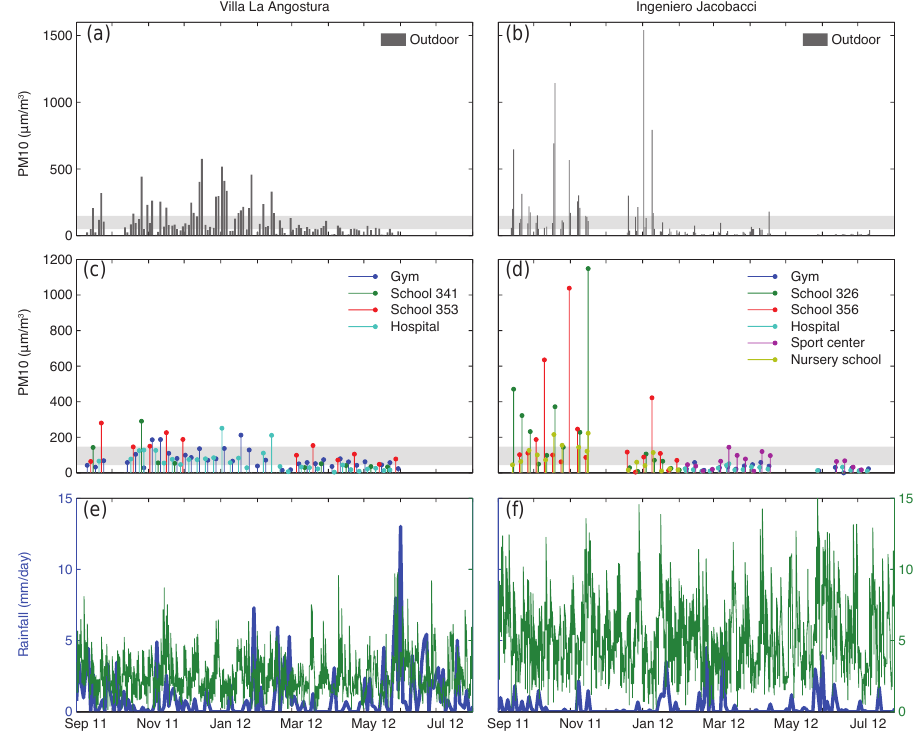
Figure 7. PM 10 concentrations between September 2011 and July 2012 for (a) Villa La Angostura (outdoor station), (b) Ingeniero Jacobacci (outdoor station), (c) Villa La Angostura (indoor measurements) and (d) Ingeniero Jacobacci (indoor measurements). Shaded area indicates maximum levels for a 24h exposure (150µgm − 3 ) and for an exposure of 1 year (50µgm − 3 ). Daily rainfall and wind speed averaged